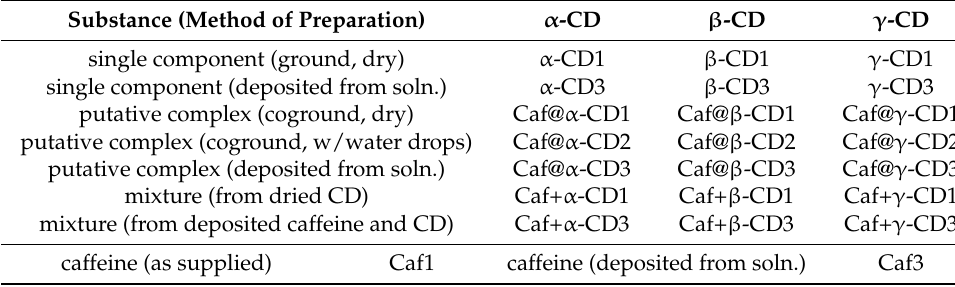
Table 1. Shorthand notations for the substances under